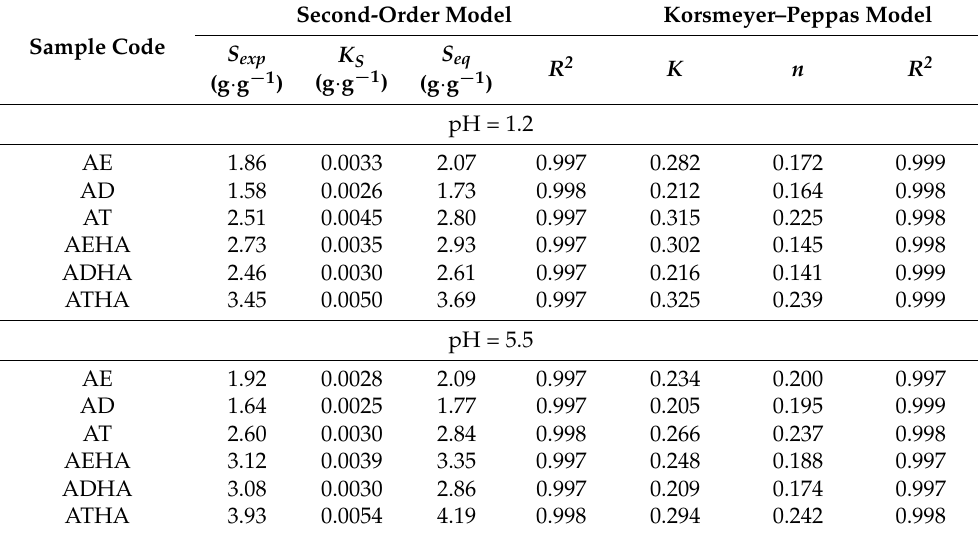
Table 7. Kinetic parameters of the swelling process in various aqueous